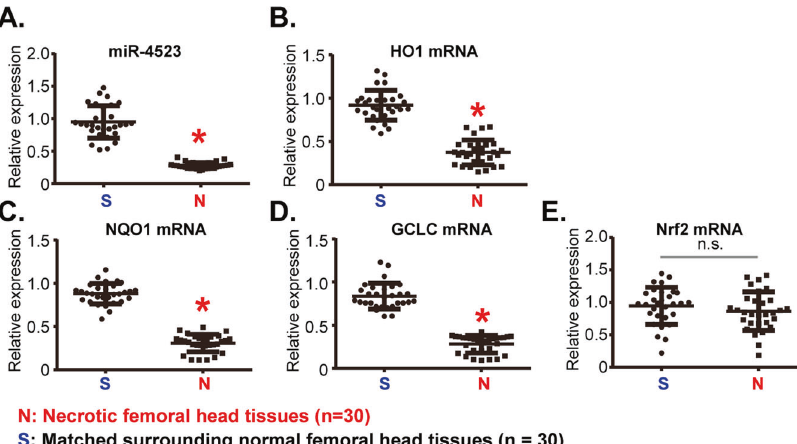
Fig. 6 miR-4523 is downregulated in human necrotic femoral head tissues. Expression of miR-4523 ( A ) and listed mRNAs ( C – E ) in necrotic femoral head tissues ( “ N ” ) and surrounding normal femoral head tissues ( “ S ” ) of 30 different DEX-taking patients were examined by qRT-PCR assays. Data were expressed as mean ± standard deviation (SD, n = 30). * P < 0.05 vs. “ S ” tissues. “ n.s. ” stands for non-statistical difference ( E ). Experiments in this fi gure were repeated three times, and similar results were